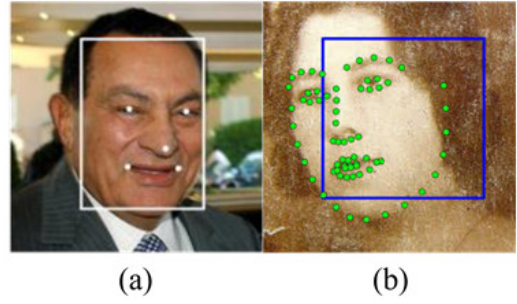
Figure 1. Comparison of ( a ) MTCNN and ( b ) DAN.